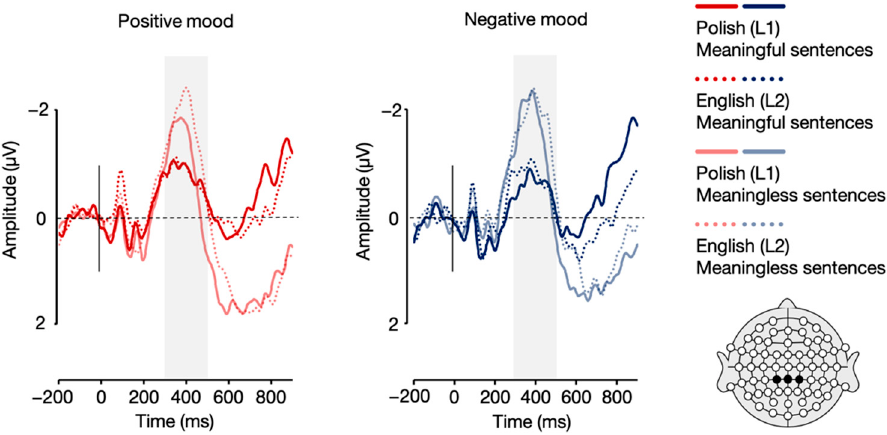
Figure 9. Grand averages for Polish (L1) and English (L2) meaningful and meaningless sentences in the positive and negative mood conditions over centro-parietal (CP1, CPz, CP2) electrodes.